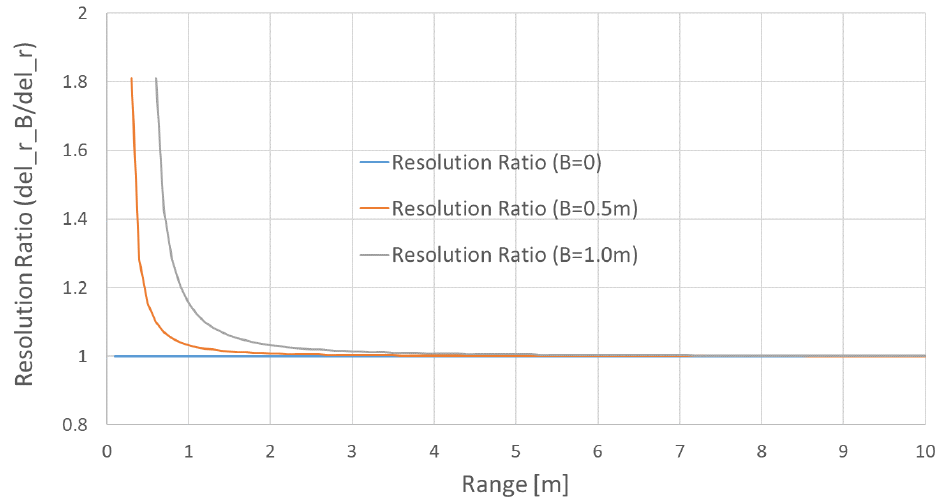
Figure 2. Range resolution ratio of bistatic and monostatic radars ( δ r B / δ r ) with different baselines B = 0 m, 0.5 m, and 1 m, respectively.